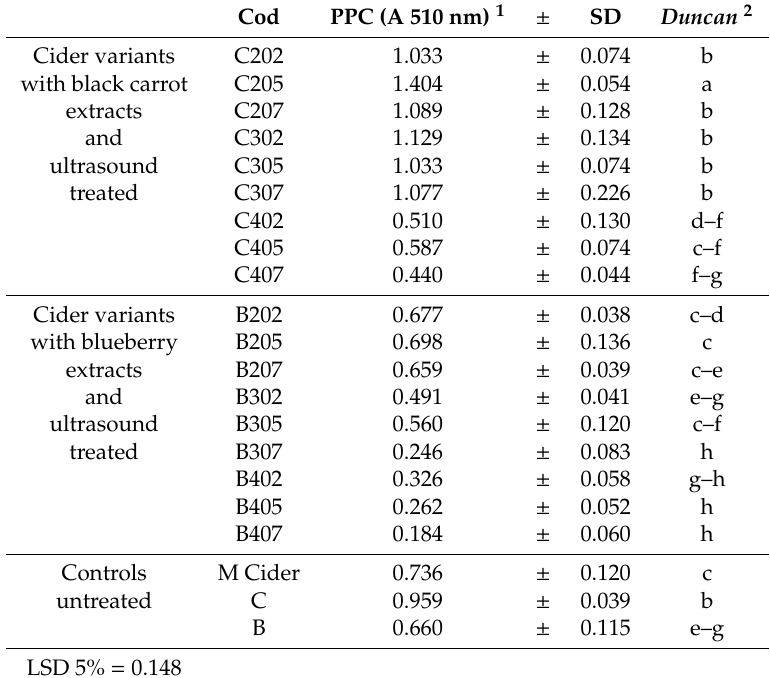
Table 6. Precipitation capacity of the cider variants with extracts added and